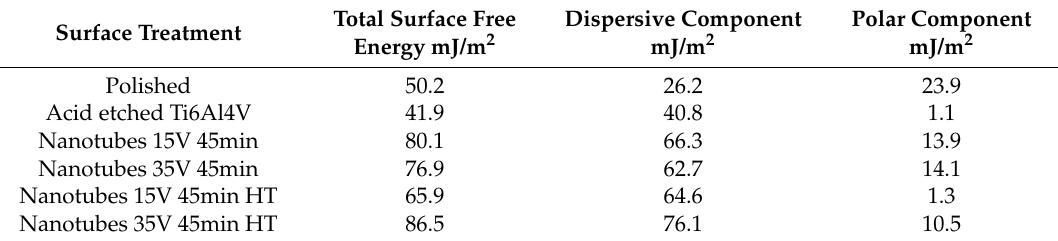
Table 5. Surface free energy for the different